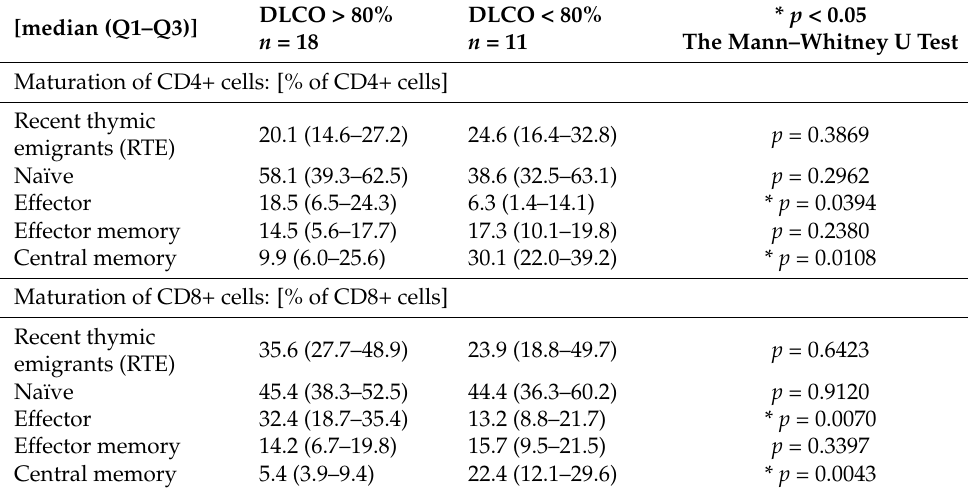
Table 3. Differences in the median proportion of T lymphocytes maturation in lymph nodes (LNs) between sarcoidosis patients with normal diffusion: DLCO > 80% and with reduced diffusion: DLCO < 80%. Data expressed as median (Q1–Q3). A * marked p < 0.05 statistically